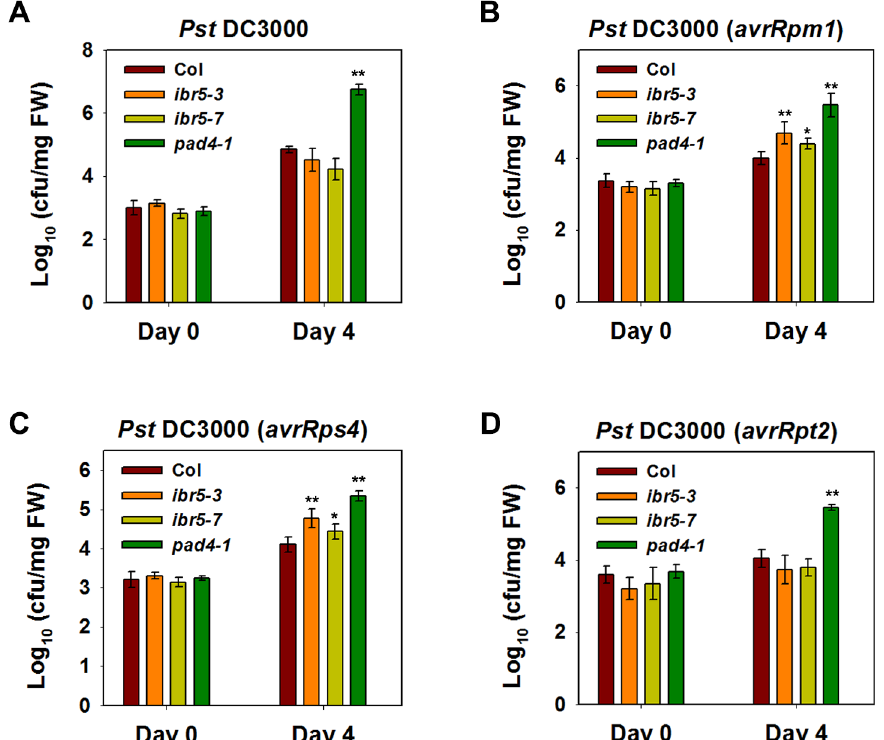
Fig 9. Pathogen resistance analysis of ibr5 mutants. (A) Response of ibr5 to P . s . t . DC3000. Three-week- old plants were dipped with P . s . t . DC 3000 (OD 600 = 0.05), and leaves were taken immediately (day 0) and at day 4 after infection. The log-transformed values presented are the mean values of three replicates ± SD. (B-D) Responses of ibr5 to avirulent bacteria. Three-week-old plants were dipped with P . s . t . DC3000 ( avrRpt2 ) (B), P . s . t . DC3000 ( avrRpm1 ) (C) and P . s . t . DC3000 ( avrRps4 ) (D) (OD 600 = 0.2). In (A-D), the log- transformed values presented are the mean values of three replicates ± SD, and the asterisks indicate significant differences compared with wild-type Col ( ** P < 0.01, * P < 0.05, t -test). All experiments were repeated at least three times with similar